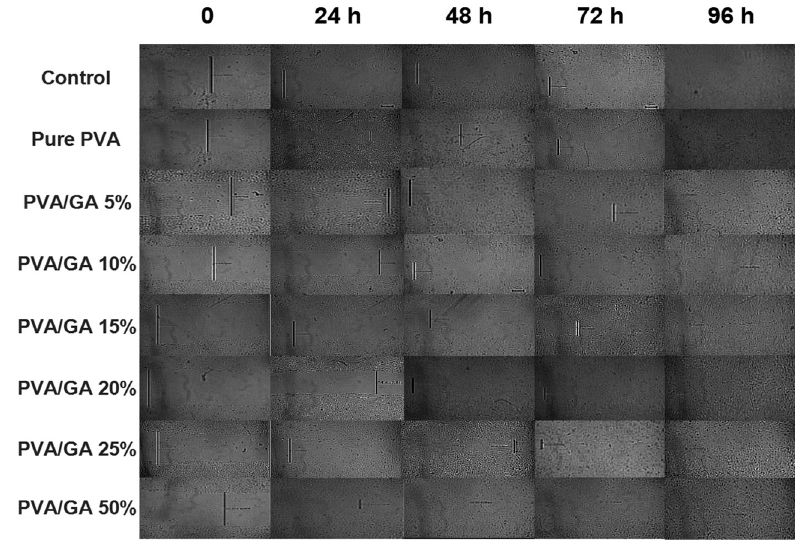
Figure 7: Inverted microscope images of percentage of original wound area for control, pure PVA, and the PVA/GA x hydrogels. Concentrations ( x ) of GA are from 5% to